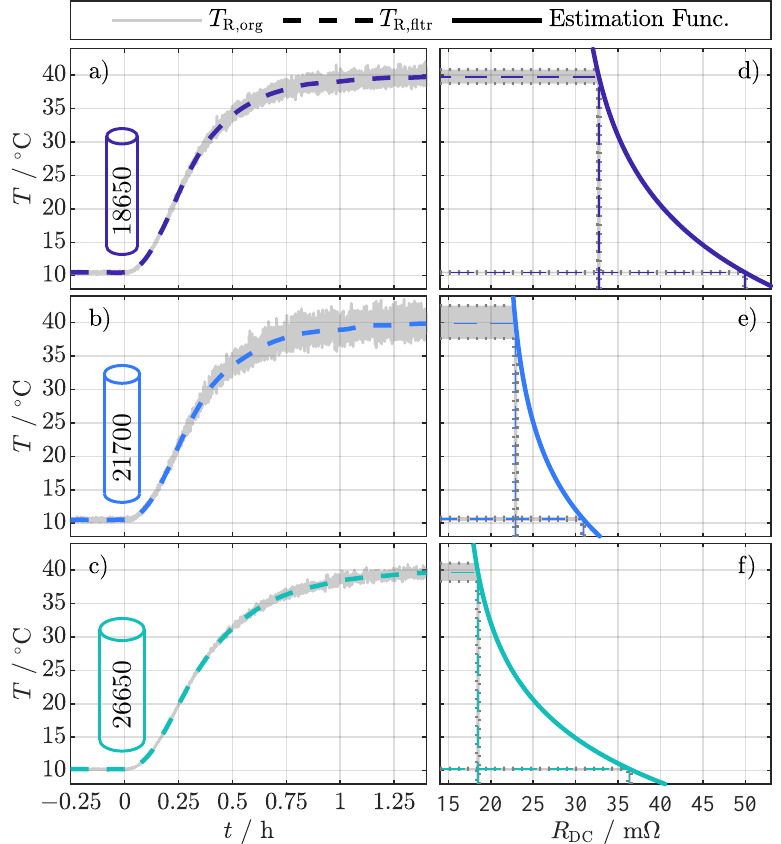
Figure 3. Exemplary temperature estimation results for the investigated cell formats 18650 ( a ), 21700 ( b ), and 26650 ( c ) at a SOC of 50% evaluated with Equation (4) and the setting according to Table 4. T R,org shows the originally calculated values and T R,fltr shows the values filtered with a moving average filter. The different and increased noise can be related to the individual slopes of the estimation functions in ( d – f